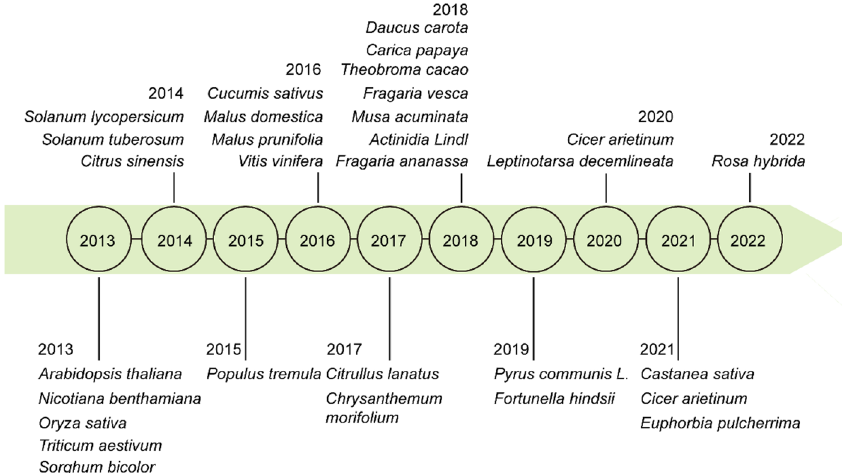
Fig. 1 Timeline of CRISPR/Cas9 system was first applied in different plant